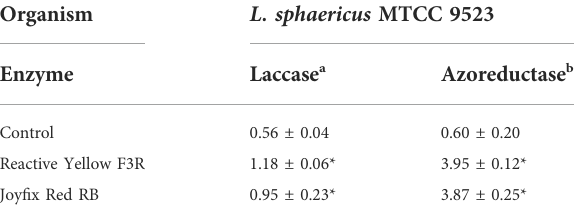
TABLE 2 Laccase and azoreductase enzyme activities of L. sphaericus MTCC 9523 before and after dye